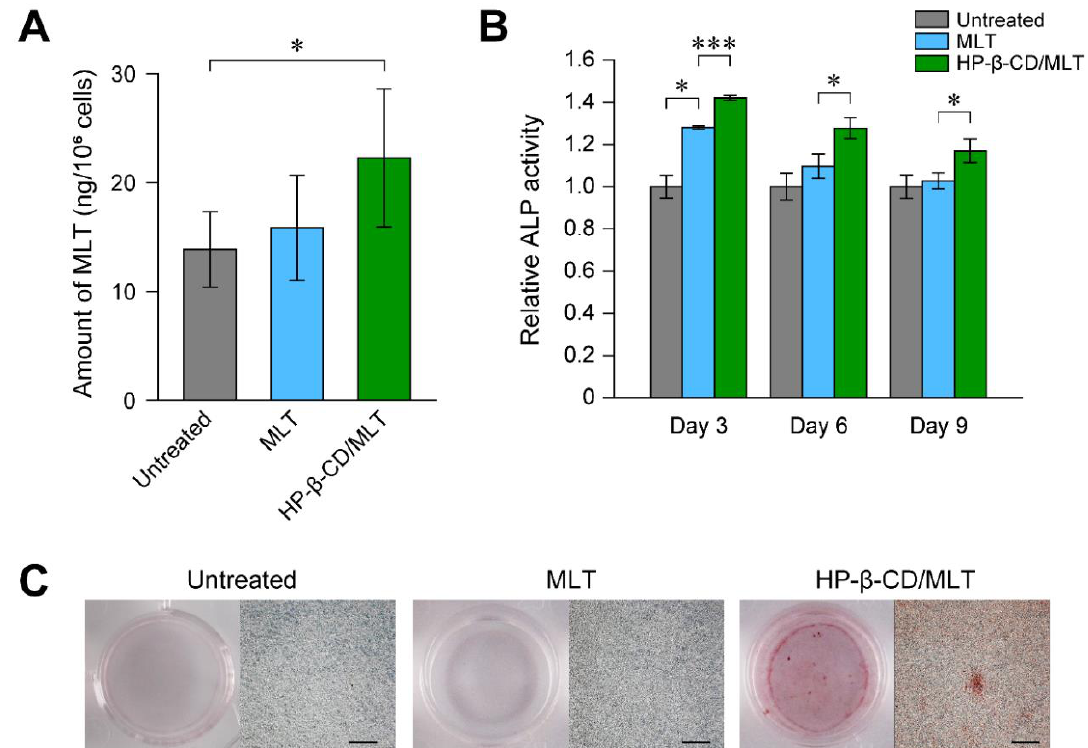
Figure 4. ( A ) Intracellular amount of melatonin (MLT) in MC3T3-E1 cells treated with free MLT (MLT: 1 µ M) and HP- β -CD/MLT inclusion complexes (MLT: 1 µ M, HP- β -CD: 1 µ M) for 24 h. Data are expressed as the mean ± S.D. ( n = 3, * p < 0.05). ( B ) Relative ALP activities in MC3T3-E1 cell treated with free MLT (100 nM) and HP- β -CD/MLT inclusion complexes (MLT: 100 nM, HP- β -CD: 100 nM) for 3, 6, and 9 days. Data are expressed as the mean ± S.D. ( n = 3, * p < 0.05, *** p < 0.005). ( C ) Mineralized matrix formation of MC3T3-E1 cells as detected by staining with alizarin red. The cells were treated with free MLT (MLT: 100 nM) and HP- β -CD/MLT inclusion complexes (MLT: 100 nM, HP- β -CD: 100 nM) for 28 days (scale bars: 500 µ m). Reproduced with permission from [79] © 2018